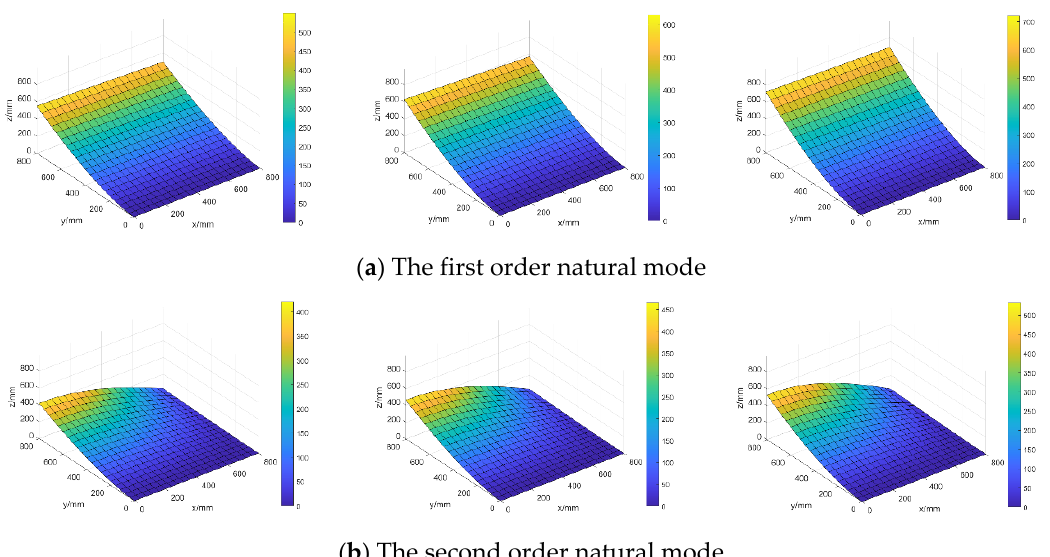
ρ simultaneously.